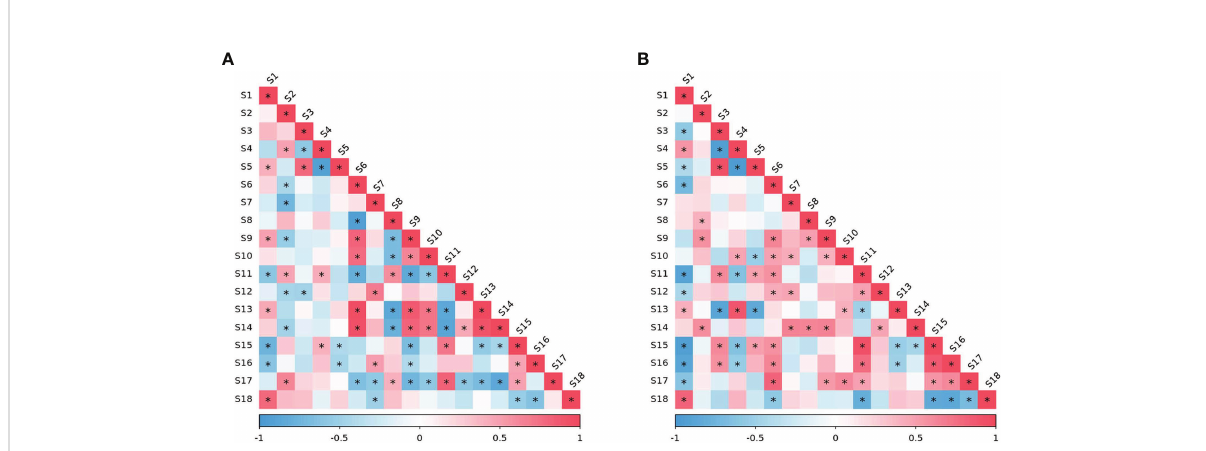
FIGURE 8 Pearson correlation values between the EL-LT50 (in °C) of vine one-year-shoots and other indicators under BLF and CK treatments in overwintering period of 2020 (A) and 2021 (B) . S 1 : EL-LT50; S 2 : total water; S 3 : free water; S 4 : bound water; S 5 : free water/bound water; S 6 : soluble protein; S 7 : free proline; S 8 : superoxide anion; S 9 : malondialdehyde; S 10 : superoxide dismutase; S 11 : peroxidase; S 12 : catalase; S 13 : ascorbic acid; S 14 : reduced glutathione; S 15 : soluble sugar; S 16 : reducing sugar; S 17 : sucrose; S 18 : starch. “ * ” means that the correlation between the two indicators is signi fi cant at the 0.05